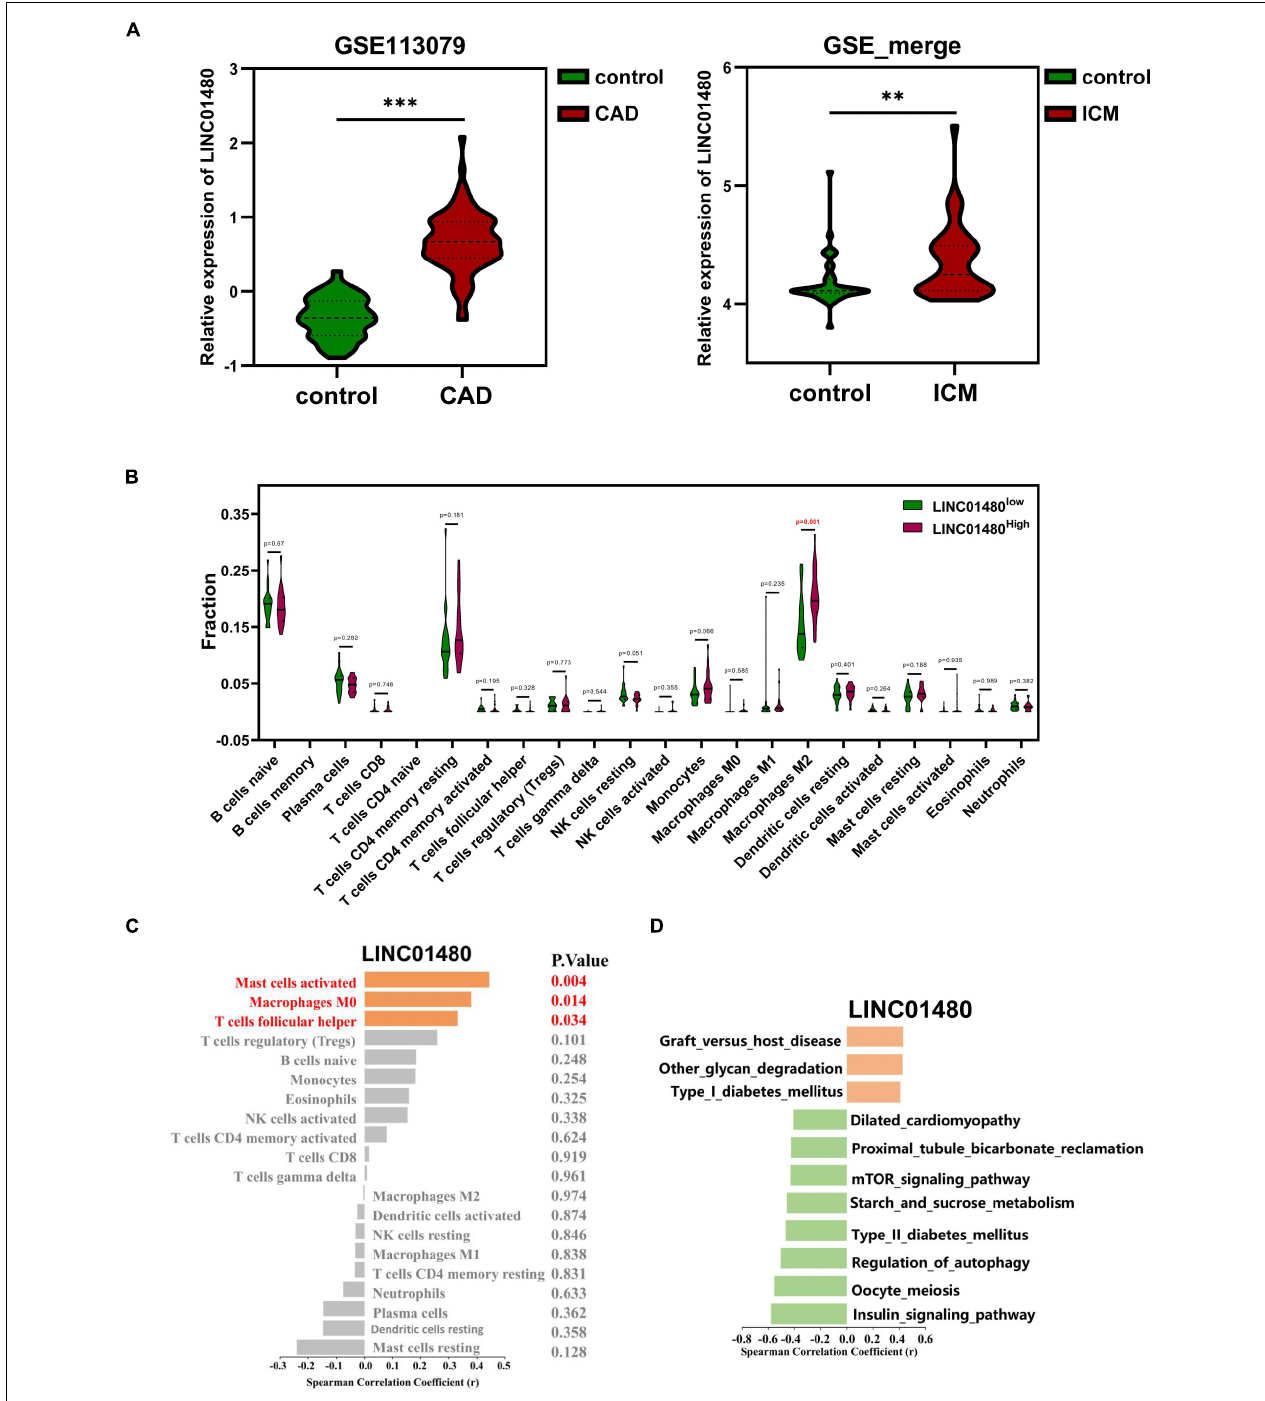
FIGURE 8 | Correlation of the proportion of infiltrating immune cell with the expression of LINC01480. (A) LINC01480 showed significant upregulation both in CAD dataset (GSE113079) and ICM datasets (GSE_merge, matrix of the merged and removing batch effects of GSE48166, GSE116250, GSE46224, and GSE120825). (B) Violin plot showing the ratio of differentiation of 22 kinds of immune cells among the ICM samples with low or high expression levels of LINC01480 relative to the median of LINC01480 expression level; Wilcoxon rank-sum test was used as the significance test. The red mark indicates the difference in the infiltration between the two groups of samples. (C) Spearman’s correlation analysis of LINC01480 and the infiltrating immune cells; immune cells with statistically significant were marked in red color with P < 0.05. (D) Spearman’s correlation analysis of LINC01480 and GSVA scores of the KEGG pathways; the statistically significant pathways were visualized with P < 0.01. CAD, coronary artery disease; ICM, ischemic cardiomyopathy; KEGG, Kyoto Encyclopedia of Genes and Genomes; GSVA, gene set variable analysis. 0.001 < ** P < 0.01, *** P < 0.001.